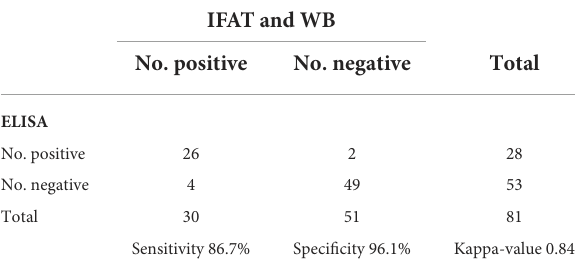
TABLE 3 Examination of anti- N. caninum antibodies from field samples with ELISA in